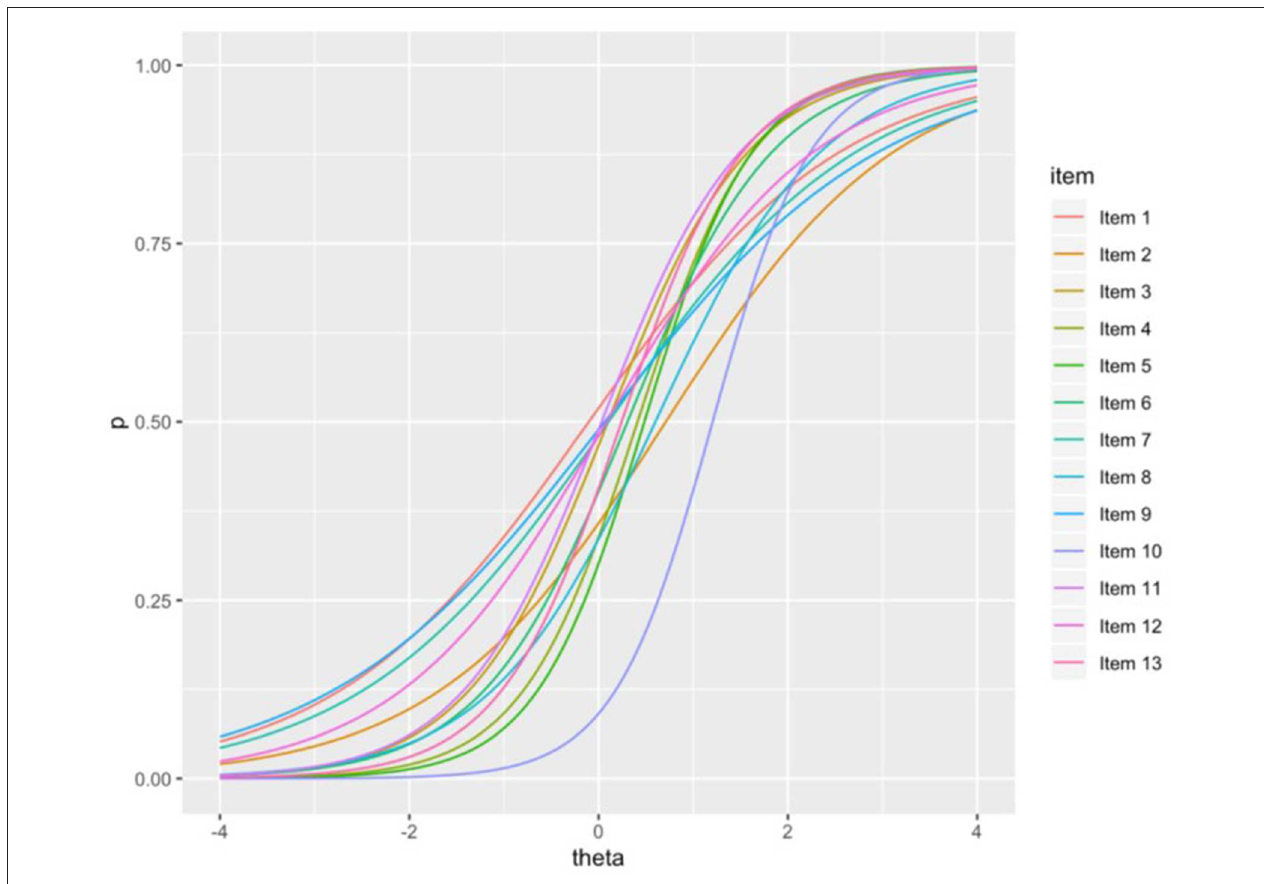
FIGURE 1 | 2PL IRT item response function.